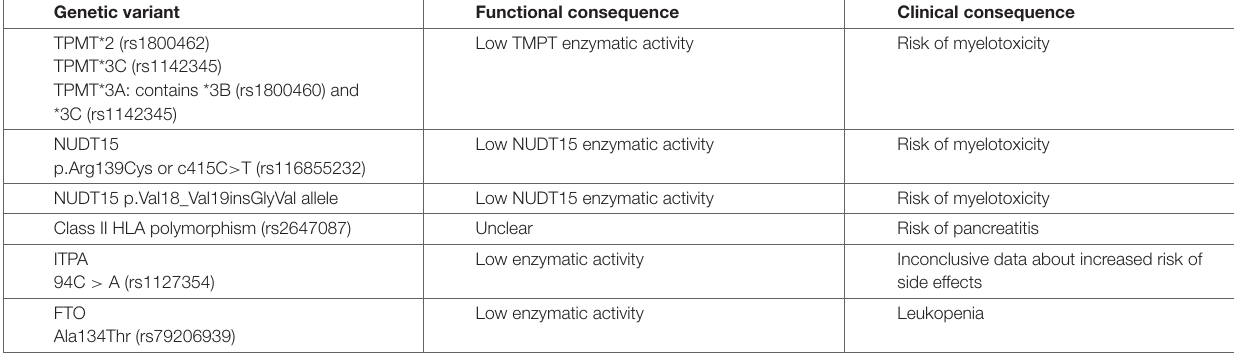
TABLE 1 | Most important genetic variants associated with thiopurine toxicity. Genetic variant Functional consequence Clinical